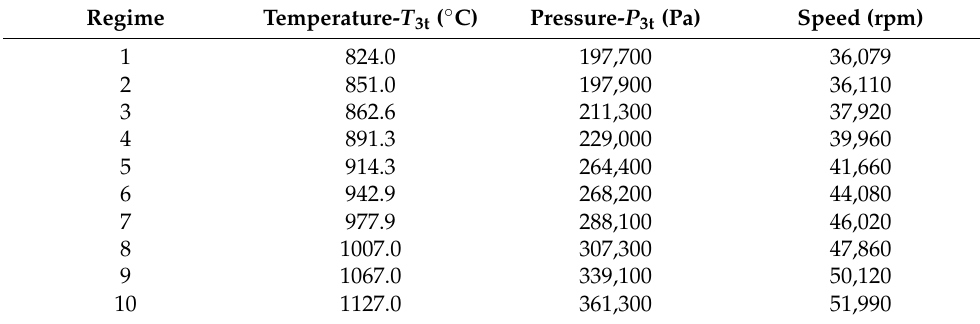
Table 1. Overview of boundary conditions for the computational fluid dynamics (CFD) analyses. Regime Temperature- T 3t ( ◦ C) Pressure- P 3t (Pa) Speed